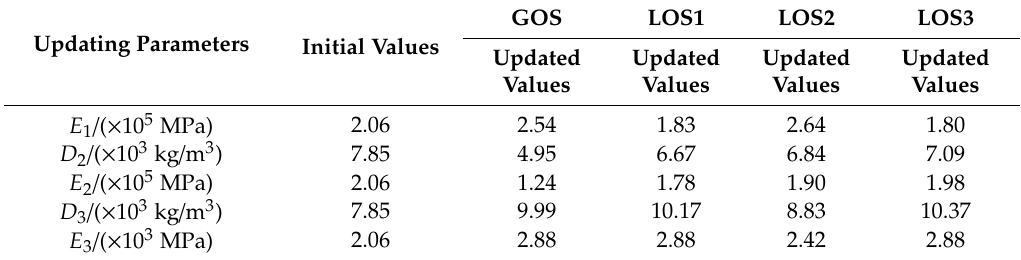
Table 10. Comparison of parameters before and after updating.